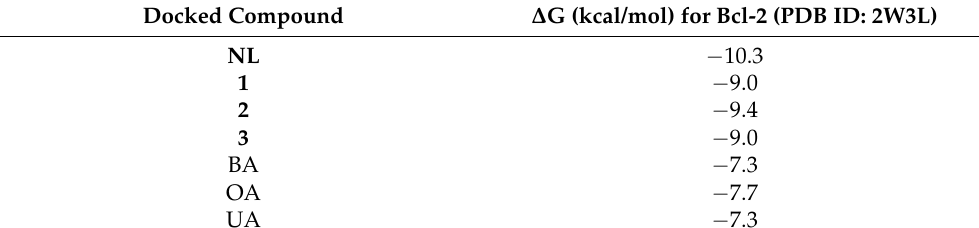
Table 1. Bcl-2 docking scores for compounds 1 – 3 , BA, OA, and UA (binding energy, ∆ G kcal/mol).